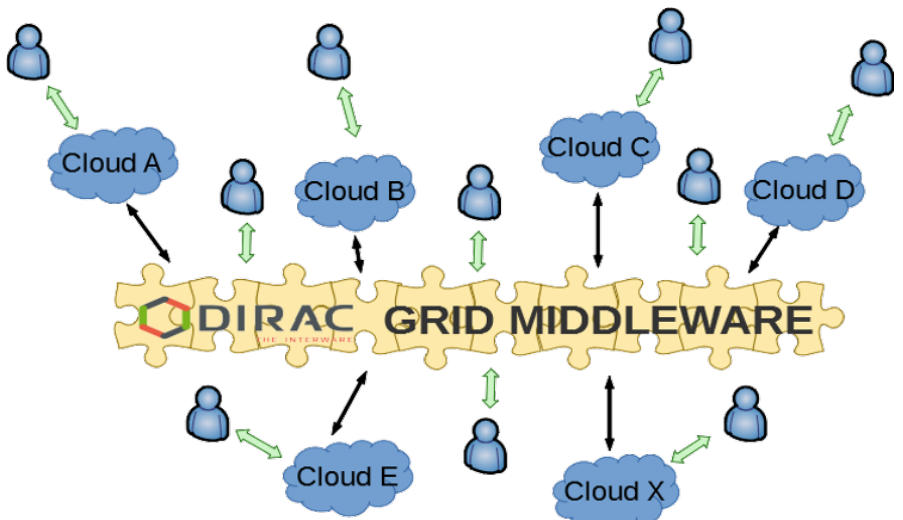
Fig. 2. Scheme of clouds integration using DIRAC grid